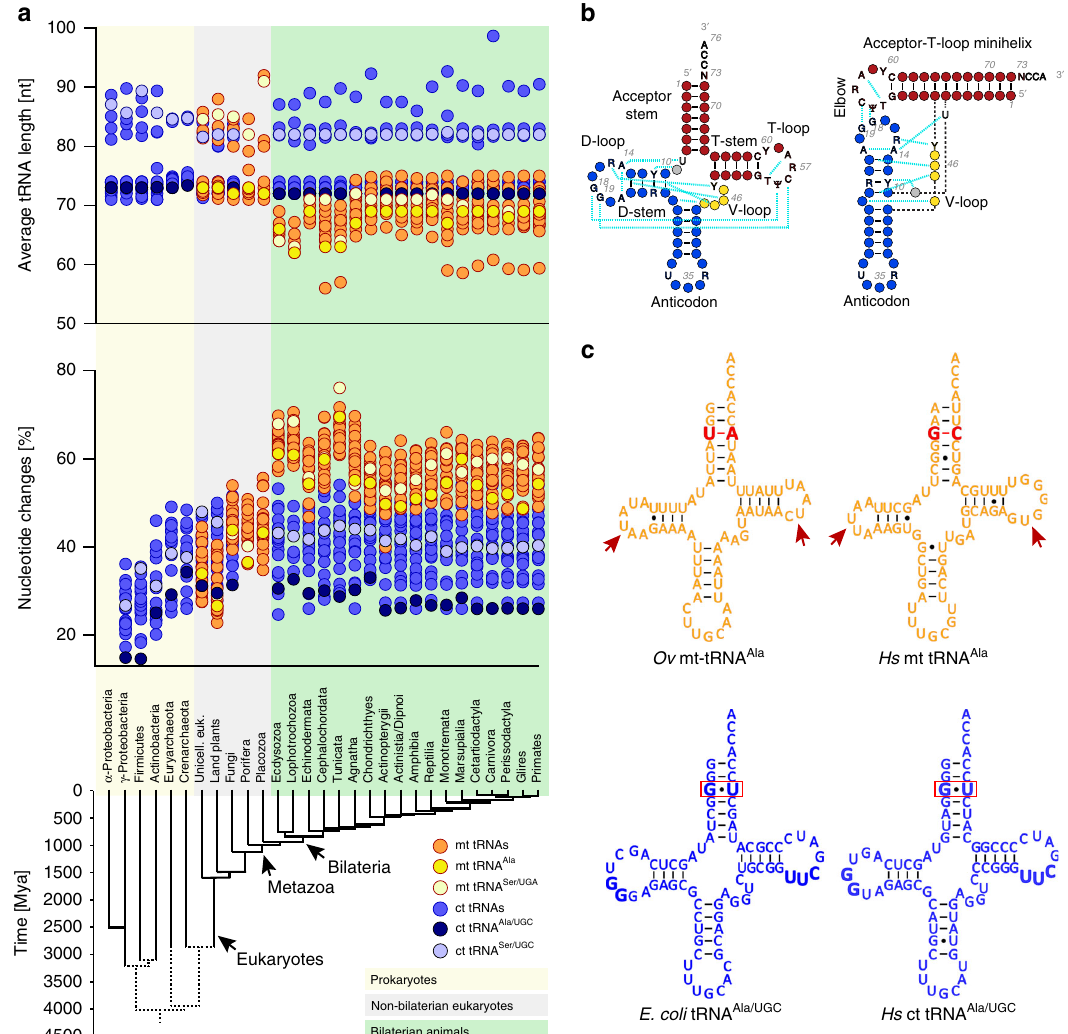
Fig. 1 Increased sequence divergence, degeneration of structural determinants and loss of sequence identity elements in bilaterian mt tRNAs. a Average length (top) and sequence changes (middle) of mitochondrial (orange) and prokaryotic/cytoplasmic (ct) tRNAs (blue). The average length of ct tRNAs ranges from 72 – 74 nt to ≥ 80 nt for tRNAs with long variable arm. While non-bilaterian mt tRNAs retain canonical length distributions, average sequence length of bilaterian mt tRNAs drops signi fi cantly (Supplementary Fig. 1b) relative to cytoplasmic counterparts, with ~65 nt (mean) in protostomes ( p < 0.001) and low branching deuterostomes, and ~69 nt in vertebrates ( p <0.001). In terms of sequence divergence in tRNAs (middle), non-bilaterian mt tRNAs exhibit moderate but signi fi cant increases to ~44% sequence changes compared with ~40% ( p < 0.001) in ct tRNAs, likely linked to increased A/U content (Supplementary Fig. 1a). Bilaterian mt tRNAs accumulate substitutions further to ~64% and ~58% in protostomes and deuterostomes, respectively, compared with ~40% in ct tRNAs ( p < 0.001). Again, protostomes and low branching deuterostomes show stronger divergence than vertebrates, possibly also linked to stronger increases in A/U content. Mt tRNA Ala and mt tRNA Ser/UGA are highlighted in dark and light yellow, respectively; ct tRNA Ala and ct tRNA Ser/UGA are highlighted in dark and light blue, respectively. Each data point corresponds to one tRNA identity (Ala, Arg, etc.) within phylogenetic groups indicated below the x -axis. Sequence divergence was determined relative to α -proteobacterial tRNAs. The bottom panel shows the phylogenetic relationship and divergence times between the organismal groups for which tRNAs were compared. P -values were determined by Wilcoxon rank sum test (Supplementary Fig. 1b). Source data are provided as a Source Data fi le. b Scheme of cloverleaf and L-shaped fold of canonical tRNA with conserved structure- and sequence elements. Canonical tertiary interactions are indicated by cyan dashed lines. c Examples of mt tRNA Ala (orange) from Octopus vulgaris ( Ov ) and humans ( Hs ) and of canonical tRNA Ala (blue) from E. coli and human cytoplasm. Red boxes indicate the G3:U70 identity element. In O. vulgaris and human mt tRNA Ala , G3:U70 is replaced by U:A and G:C pairs, respectively (bold red) (see also Supplementary Figs. 1 –